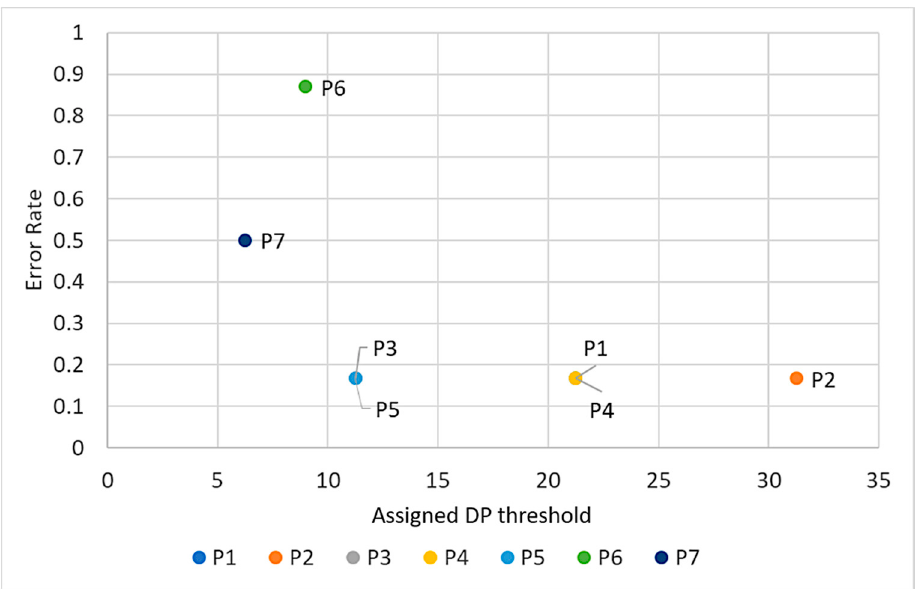
Figure 18. EER distribution obtained from all FRR–FAR curves by cross-validation for right upper arms ( f c = 40 Hz). The horizontal axis indicates the assigned DP thresholds. The vertical axis indicates the error rate. The legend shows photo-taking behavior data used as reference data. Table 4. DP matching result of dataset2 when using dataset1 as the reference data (Reference